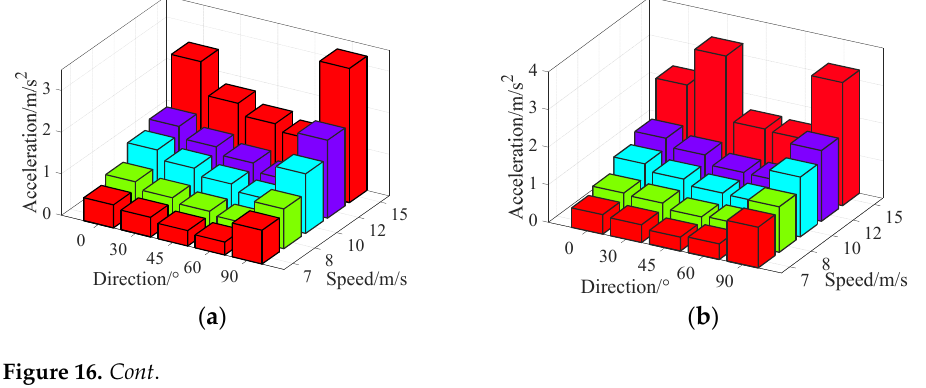
Figure 15. The installation of the five sensors.